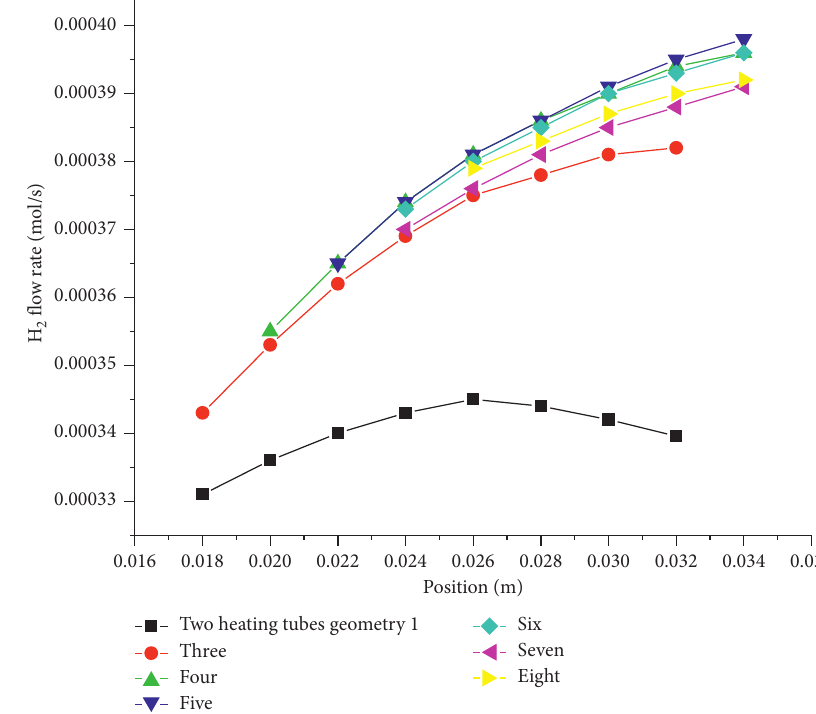
Figure 6: H2 flow rate according to the number of heating